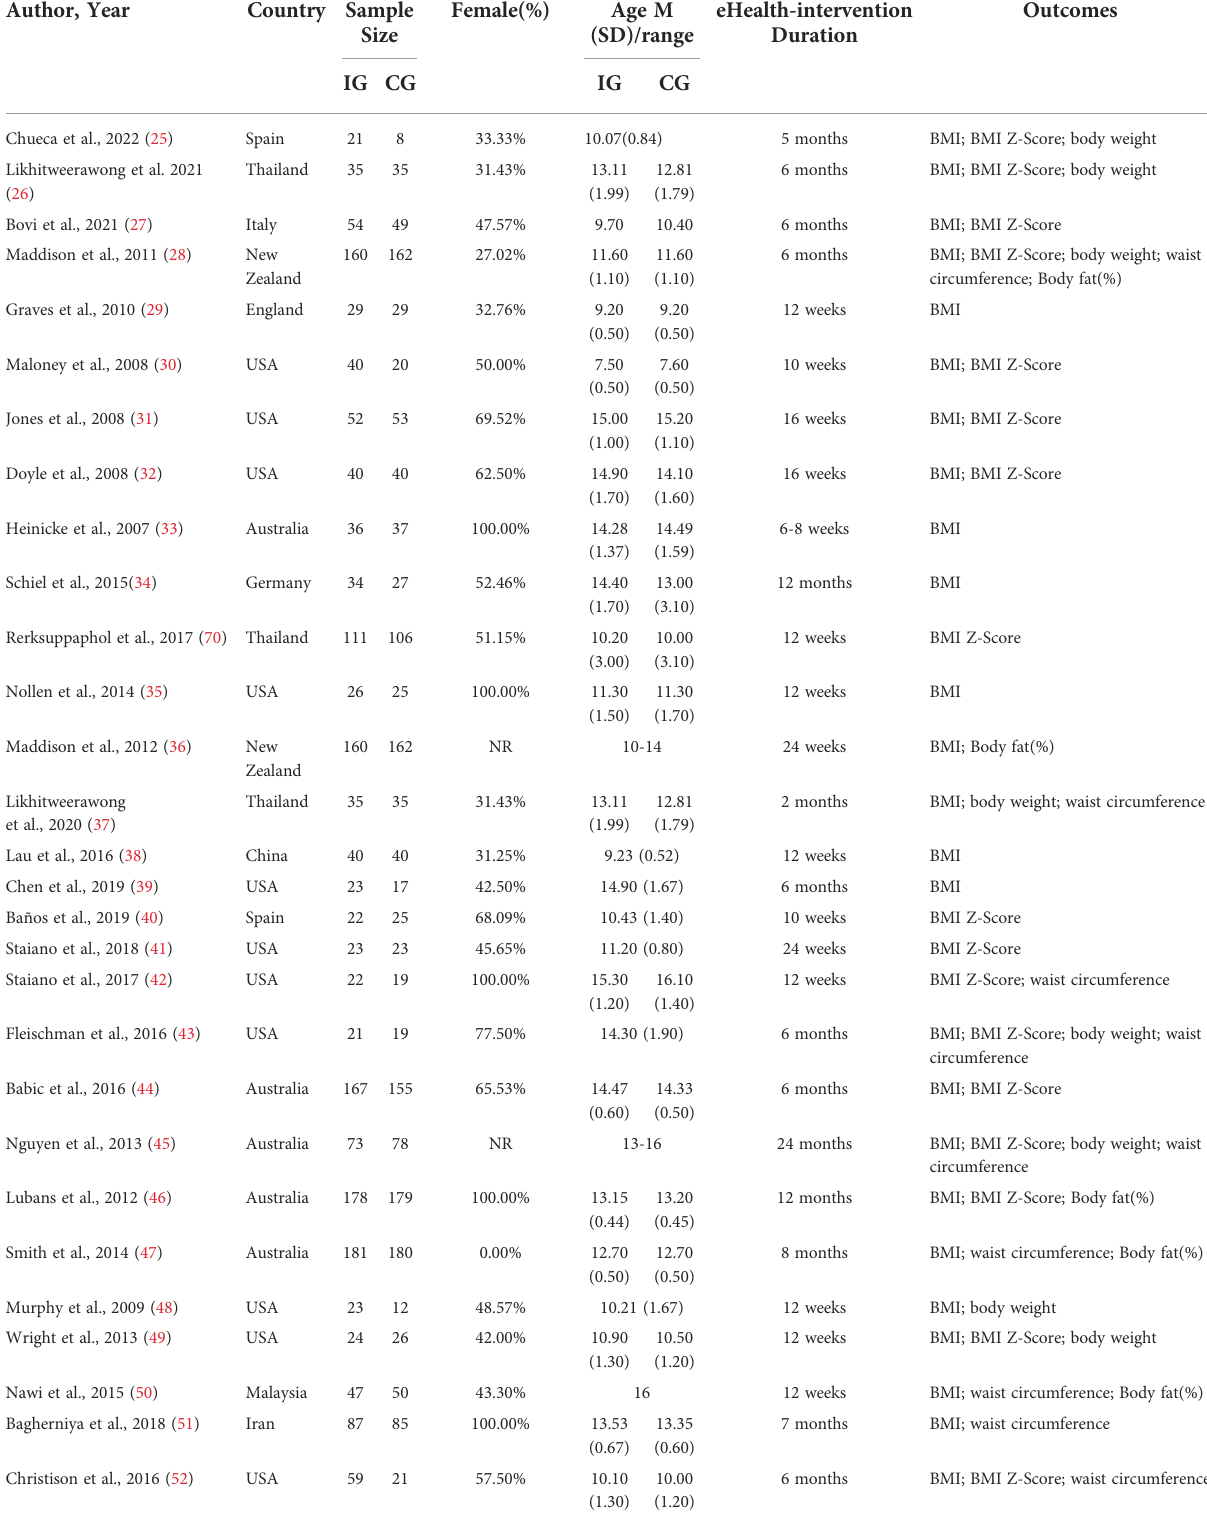
TABLE 1 Characteristics of the studies